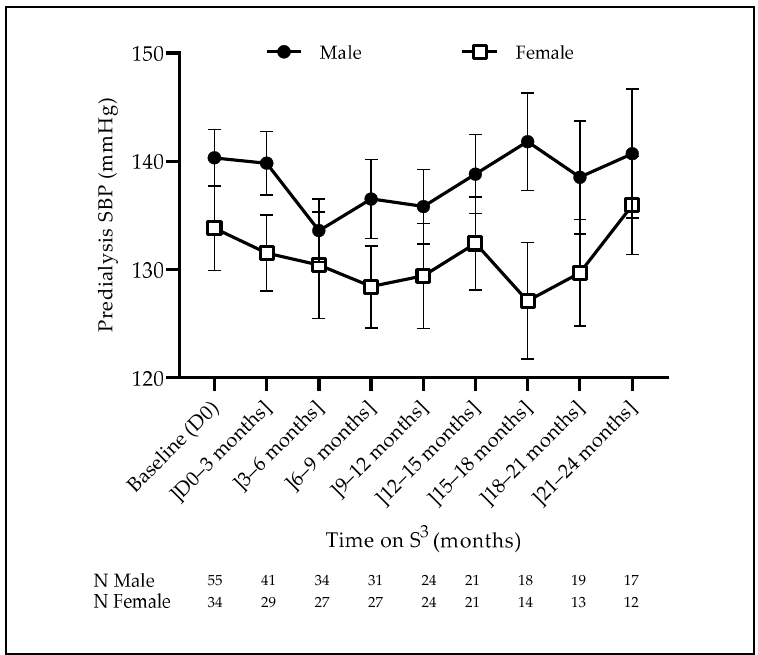
Figure 2. Evolution of the predialysis systolic blood pressure (SBP) (mean ± SEM).